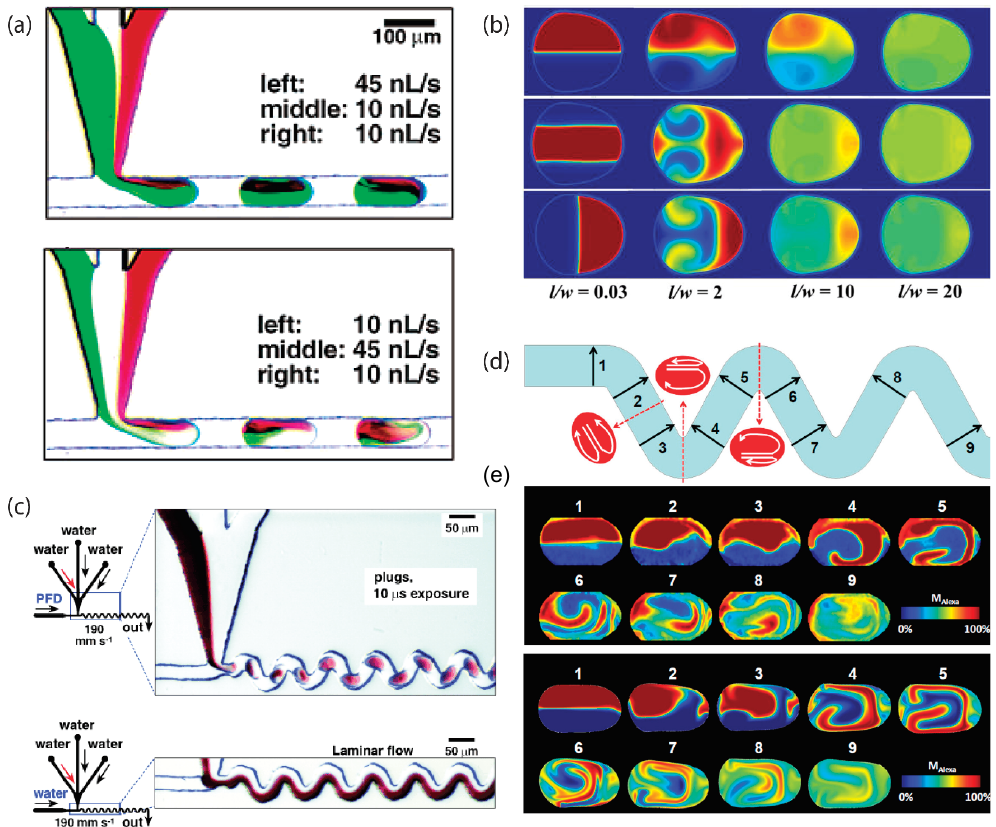
Figure 3. Spontaneous mixing of droplets flowing in straight channels for different ( a ) experimental (reprinted with permission from [14], copyright 2003 American Chemical Society), and ( b ) theoretical studies (reprinted from [40] with permission from Elsevier). While some mixing occurs reasonably fast (i.e., in a few ms) in such conditions, forced chaotic mixing in winding channels has been observed experimentally ( c ) (Copyright Wiley-VCH Verlag GmbH and Co., KGaA; reproduced with permission from [41]) and the mixing dynamics have been confirmed and analyzed in depth by theoretical calculations ( d ) (reprinted from [42], with the permission of AIP Publishing). ( e ) sequence of micrographs of the finite element analysis of the mixing occurring inside a droplet in the winding channel shown in ( d ).